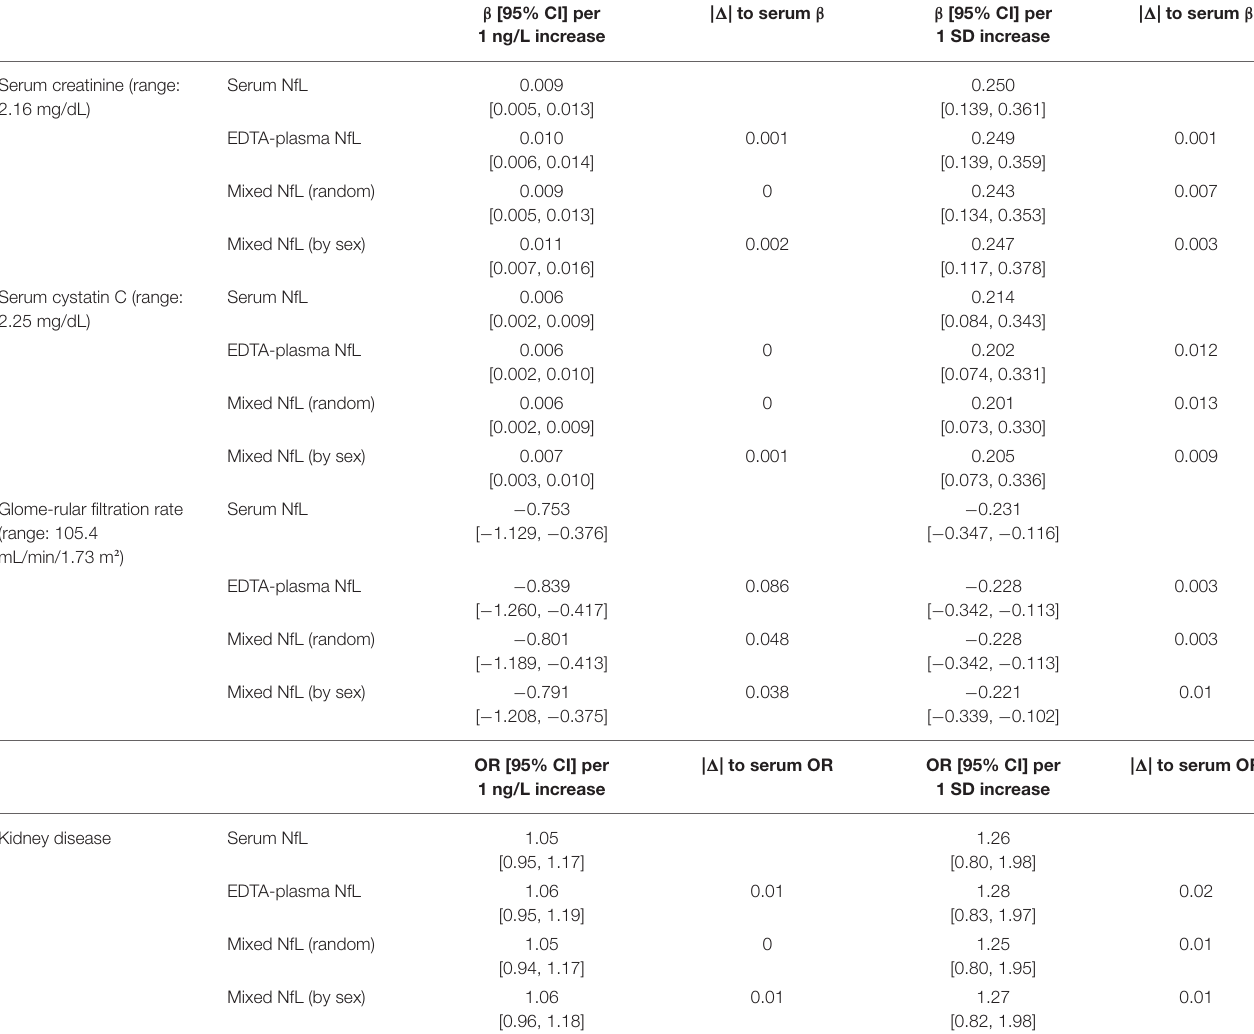
TABLE 2 | Results of regression analyses in BiDirect.